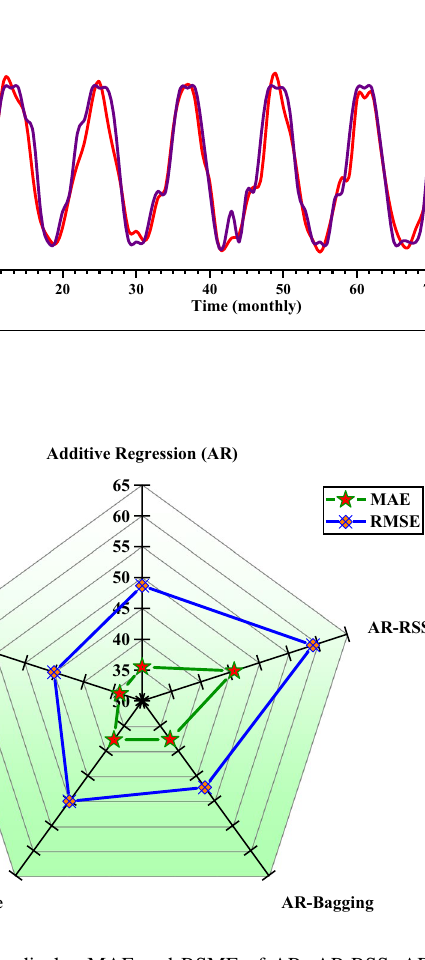
Fig. 6 Radar charts display MAE and RSME of AR, AR-RSS, AR- Bagging, AR-REPTree, and AR-M5P models during testing at Bagh- dad station